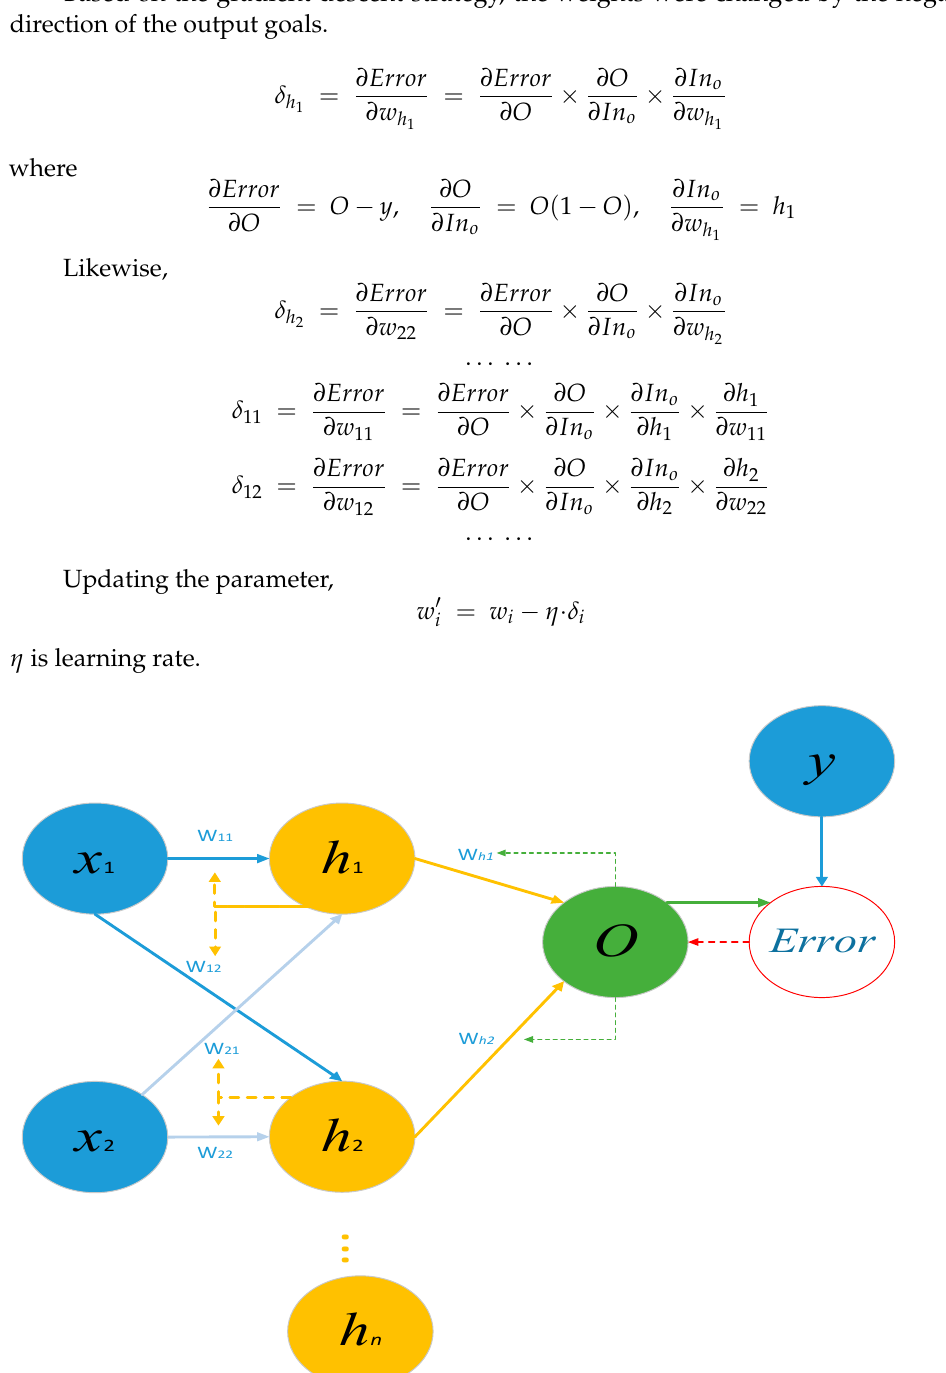
Figure 6. The typical data flow between nodes of BP algorithm with single hidden layer. Forward processing: